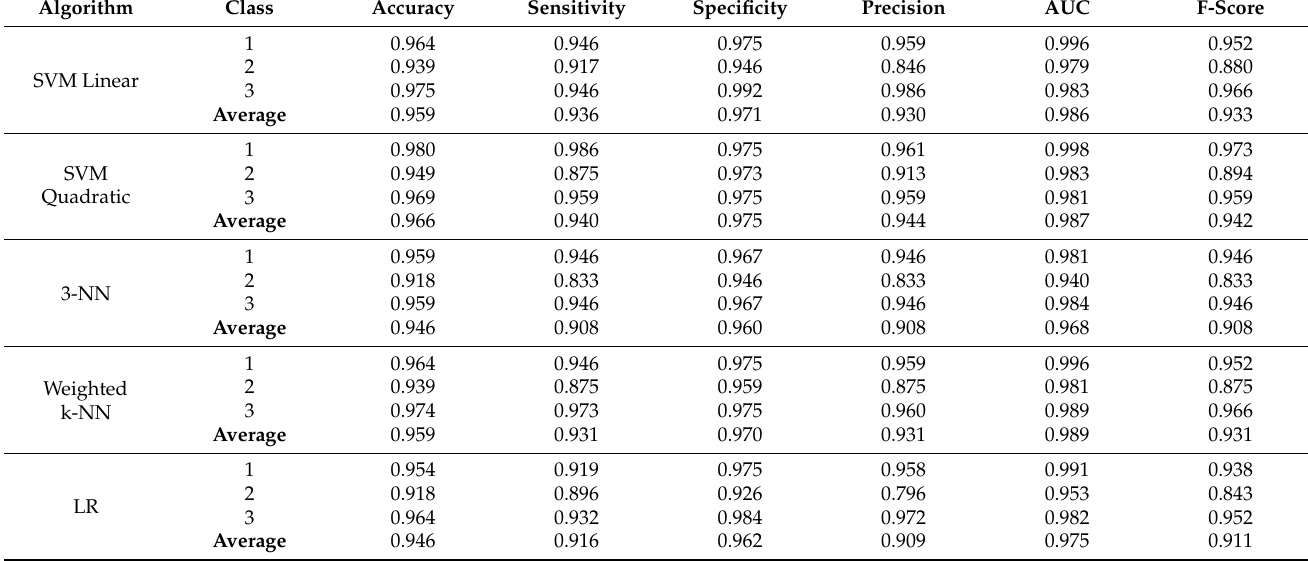
Table 5. Metrics scores for stage 2 in Model 2—multi-classification.